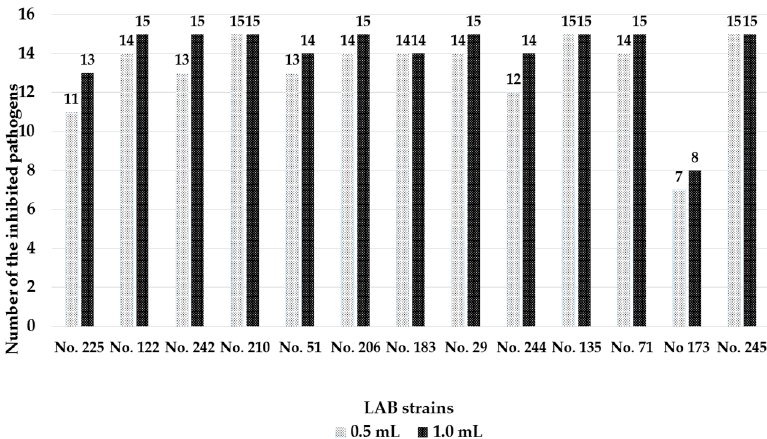
Figure 2. Antimicrobial activities of the tested lactic acid bacteria (LAB) strains and number of inhibited pathogenic opportunistic microorganisms in liquid medium. The isolated sourdough LAB encompasses: Leuconostoc mesenteroides No. 225; Lactobacillus plantarum No. 122; Enteroccocus pseudoavium No. 242; Lactobacillus casei No. 210; Lactobacillus curvatus No. 51; Lactobacillus farraginis No. 206; Pediococcus pentosaceus No. 183; Pediococcus acidilactici No. 29; Lactobacillus paracasei No. 244; Lactobacillus plantarum No. 135; Lactobacillus coryniformis No. 71; Lactobacillus brevis No. 173; Lactobacillus uvarum No. 245.